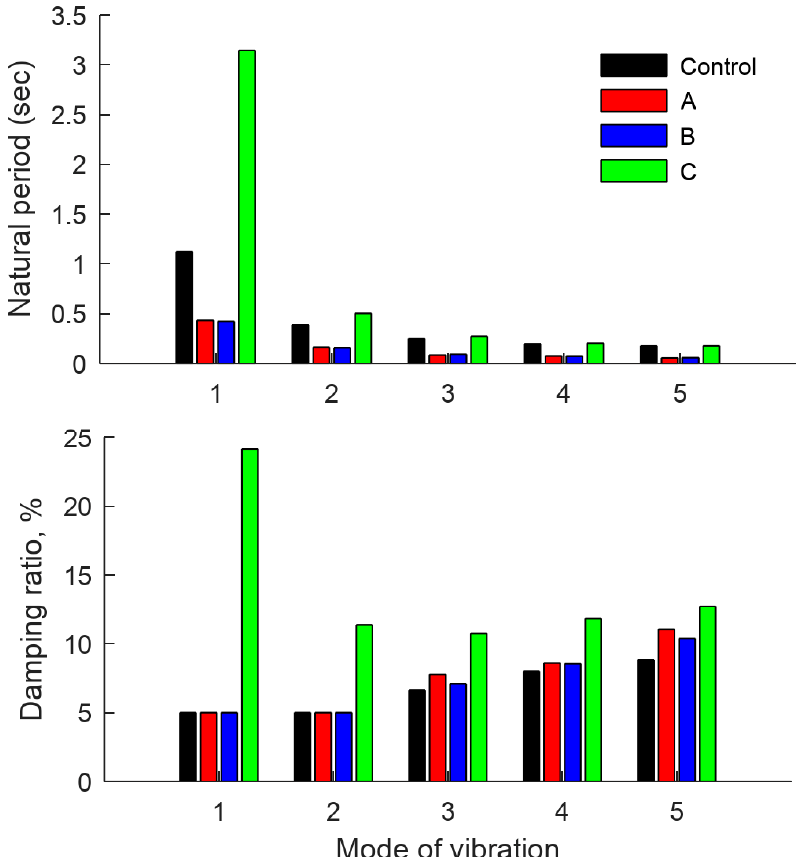
Figure 5. Comparison of the natural frequencies and damping ratios of each mode of vibration: (A) Case 1, (B) Case 2, and (C) Case 3. Table 2. Effective modal masses, as percentages of the total mass.